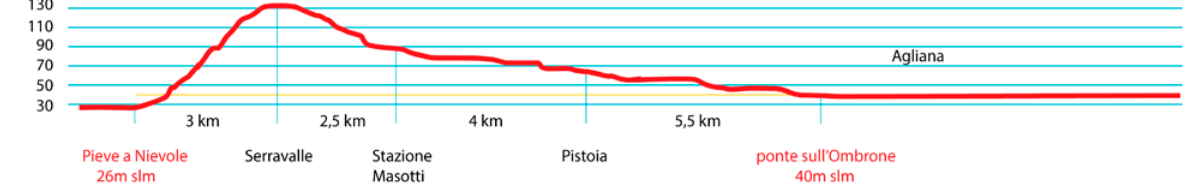
Figure 15. Topographic section between the Ombrone river and the Val di Nievole.